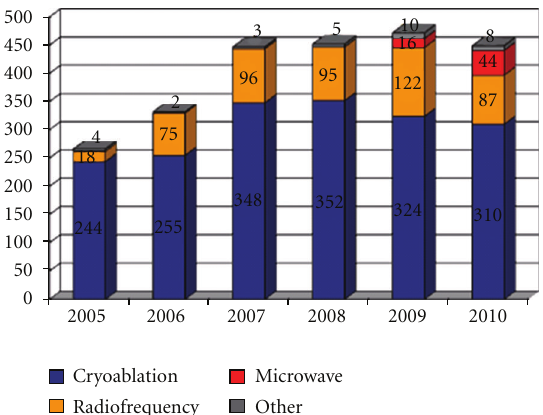
Figure 8: AF ablation at the Heart Center Leipzig 2005–2010, n = 2 . 418.